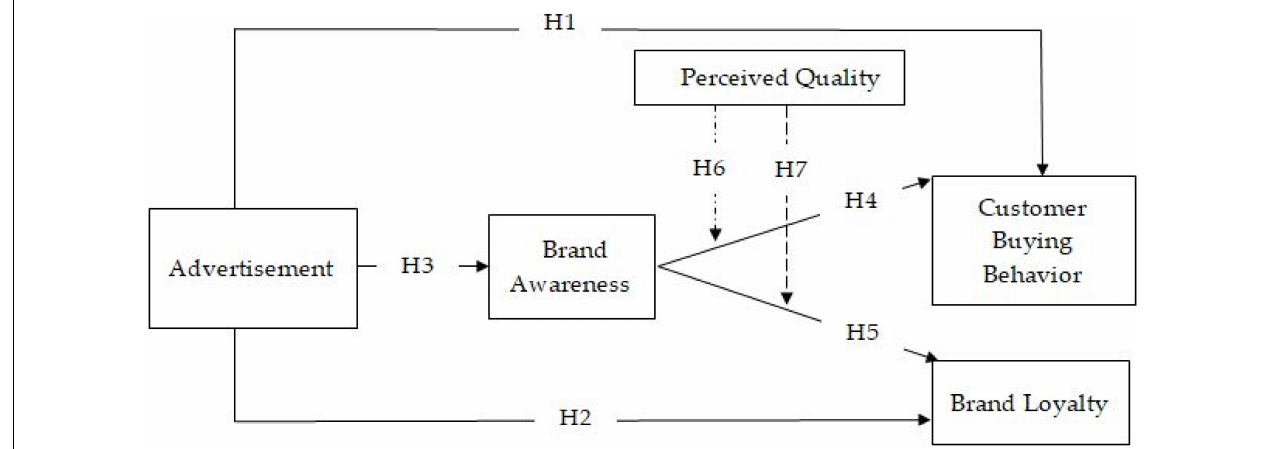
FIGURE 1 | Conceptual